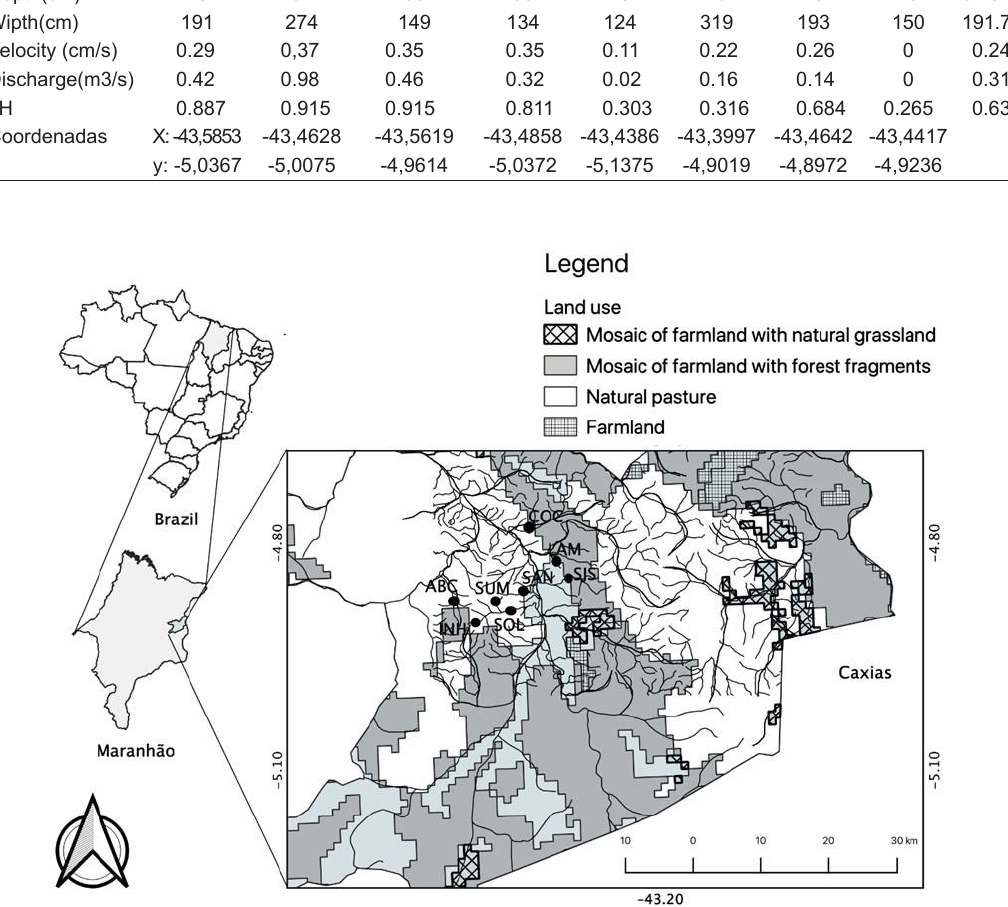
Figure 1. Samples units (streams) of the Itapecuru basin in the municipality of Caxias, Maranhão (Brazil) in the present study. Streams: Areia Branca (ABC), Cocos (COC), Inhamum (INH), Lamego (LAM), São José (SJS), Sanharó (SAN), Soledade (SOL), Sumidouro